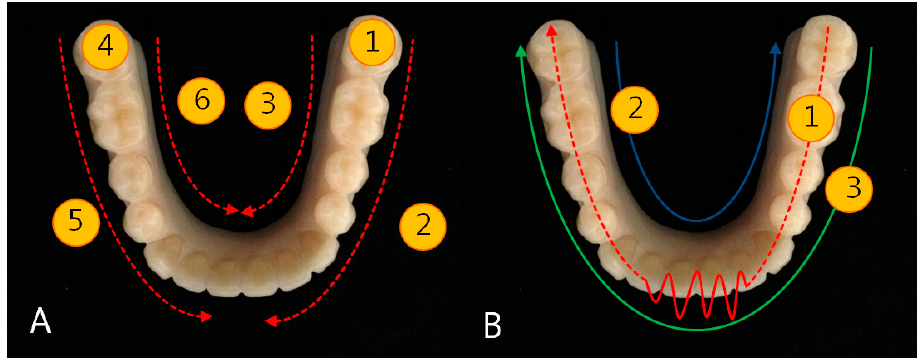
Figure 2. Scanning sequence. ( A ) iTero ® scanner: ① Scans the occlusal surface of the left-most posterior molar; ② Scans from the left-most posterior molar towards the anterior teeth, scanning the occlusal and buccal surfaces; ③ Scans from the left-most posterior molar towards the anterior teeth, scanning the lingual and occlusal surfaces; ④ Scans the occlusal surface of the right-most posterior molar; ⑤ Scans from the right-most posterior molar towards the anterior teeth, scanning the occlusal and buccal surfaces; ⑥ Scans from the right-most posterior molar towards the anterior teeth, scanning the lingual and occlusal surfaces; ( B ) Trios ® scanner. ① Scans from the left molar region to the right molar region following the occlusal surfaces; ② Scans from the right molar region to the left molar region following the lingual surfaces; ③ Scans from the left molar region to the right molar region following the buccal surfaces.